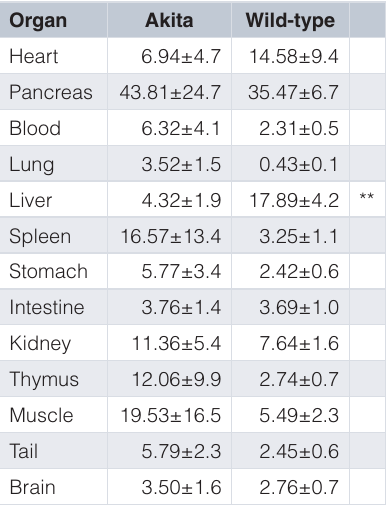
Table 1. Ex vivo biodistribution of 18 F-L- FEHTP in wt and Akita